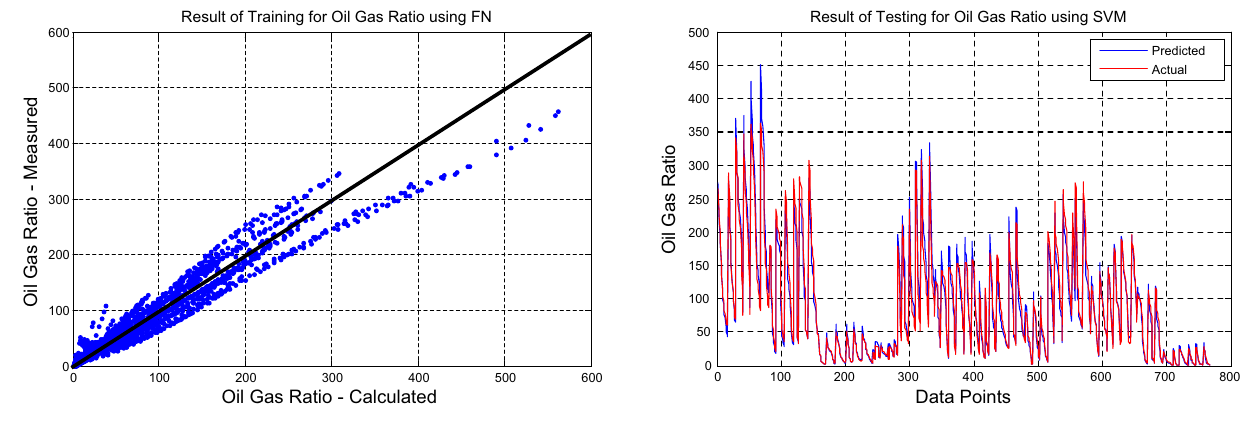
v as a function of data points using